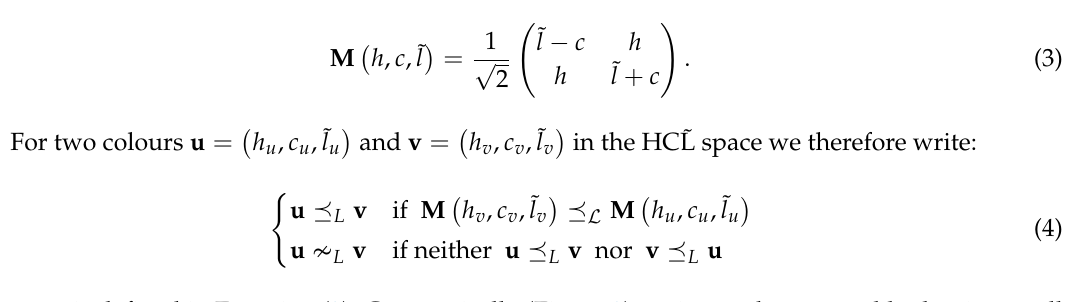
Figure 2. Loewner order in the HC˜L space: A generic colour blue volume and is dominated by all the colours in the red